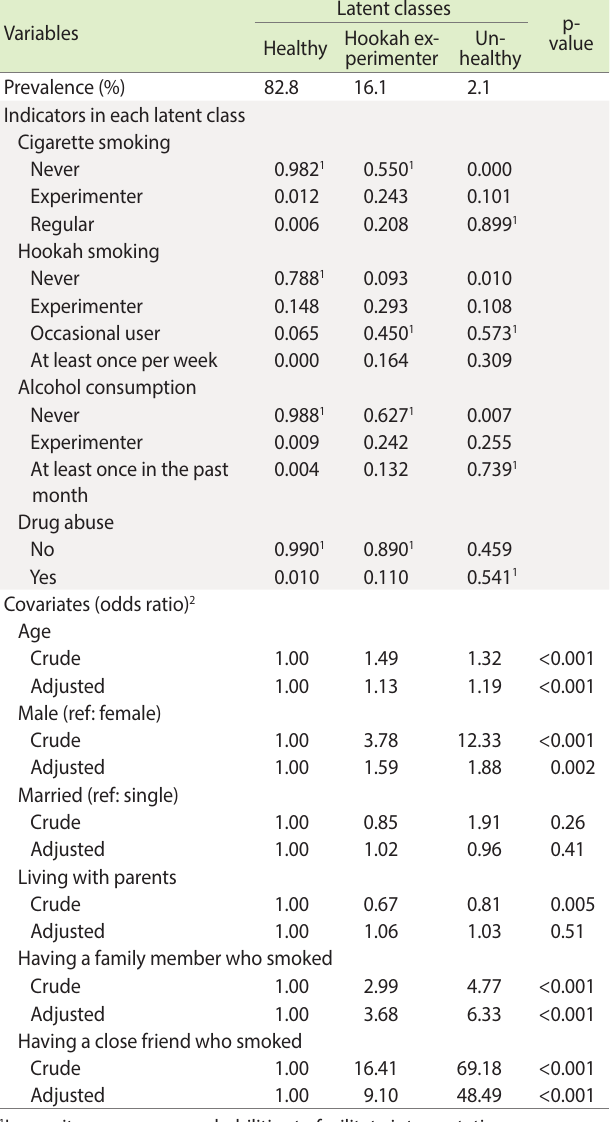
Table 3. The model of substance abuse behaviors with 3 latent